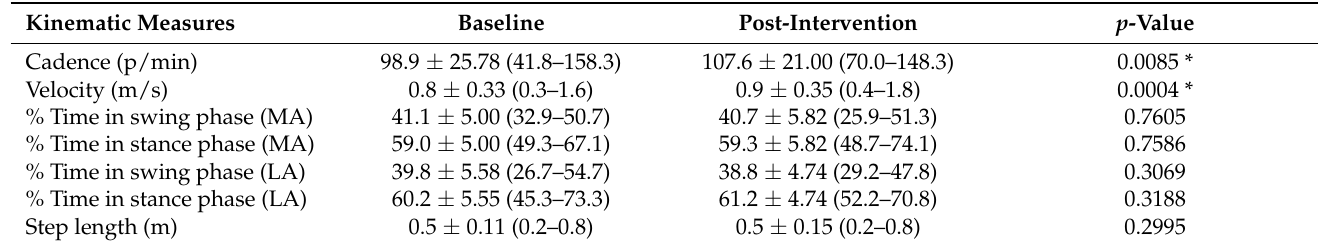
Table 2. Comparison of the spatiotemporal parameters pre- and post-training.